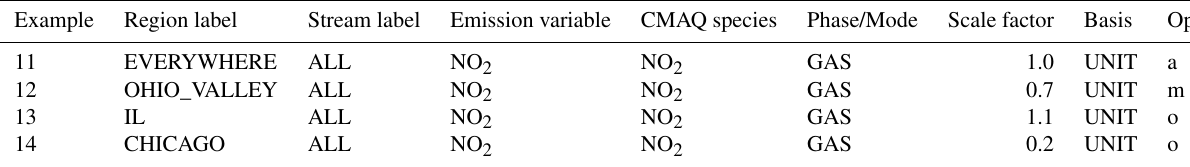
Table 5. Example scaling rules using region labels. Example